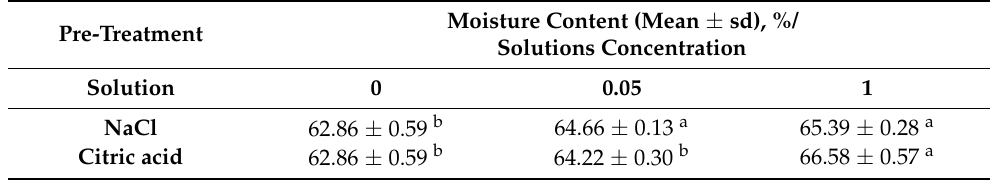
Table 2. Moisture content of French fries pre-treated with NaCl and citric acid solutions.